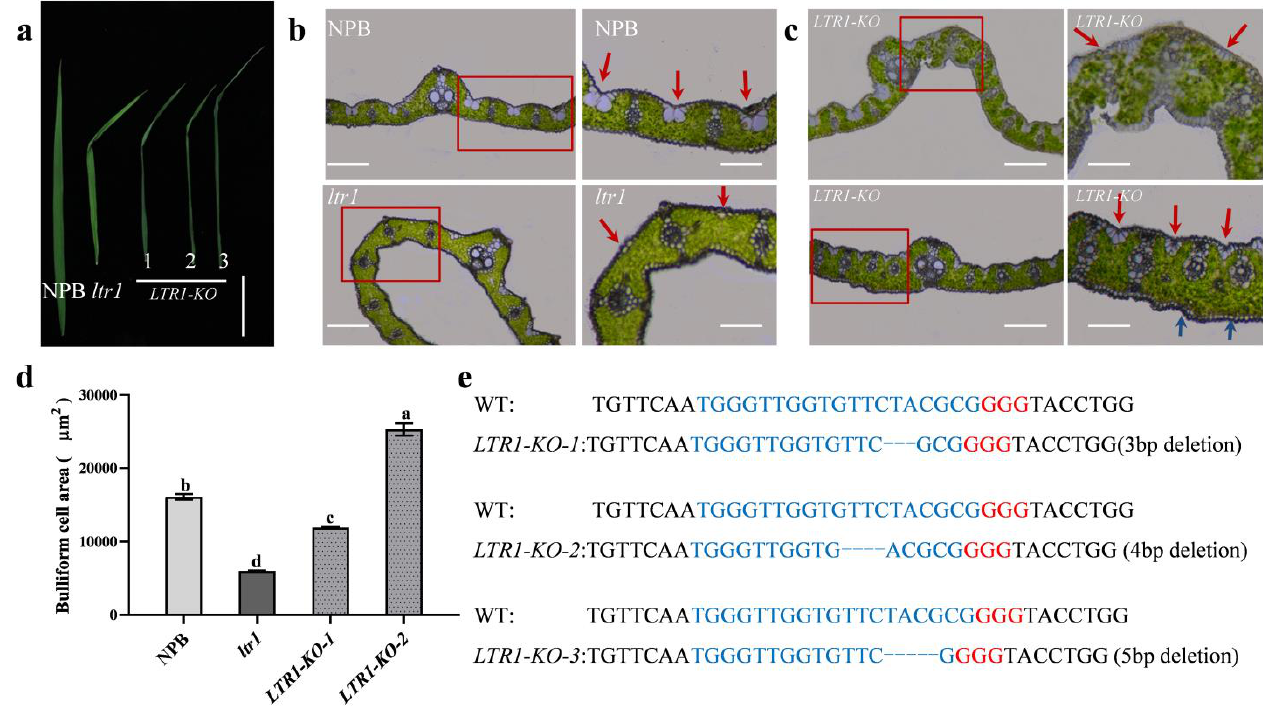
Figure 4. Phenotypic investigation of LTR1 knockout lines. ( a ) Photos of leaves in NPB, ltr1 , and LTR1-KO lines, bar = 8 cm. ( b , c ) Frozen section analysis of leaf in NPB, ltr1 , and LTR1-KO lines; the red arrow represents bulliform cells, and the blue arrow represents the location of sclerenchyma cells. Right of ( b ) is the enlarged detail of red box in the left of ( b ), bar = 200 µ m. Right of ( c ) is the enlarged detail of red box in the left of ( c ), bar = 100 µ m. ( d ) The area of bulliform cells of LTR1 knockout lines. ( e ) Sequence analysis of WT and LTR1-KO . Data are given as means ± SD. Significant differences were determined by Duncan’s new multiple range test and indicated with different lowercase letters ( p <